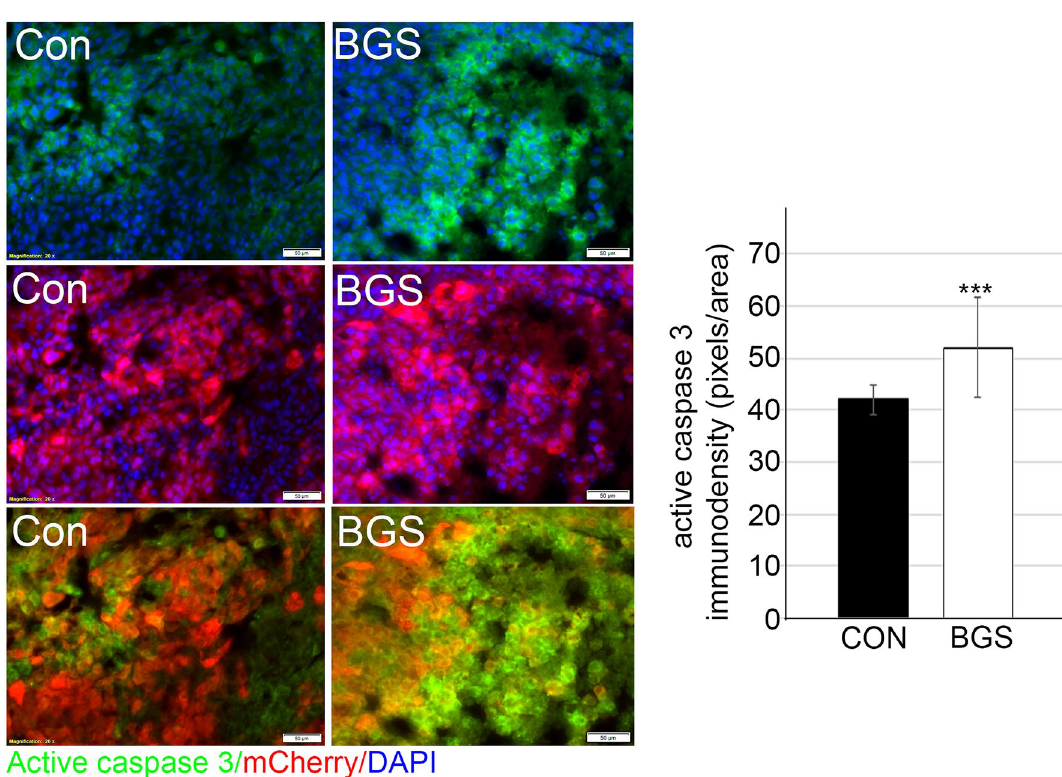
Figure 5. BGS treatment increases RET cell apoptosis. Representative images of the control and BGS treatments for active caspase-3 apoptotic marker expression (green) in the tumor (mCherry). Active caspase-3 density is significantly increased in the BGS-treated group compared to the control group. Results are presented as mean ± SD (n = 7 animals/group; ***p < 0.001). Scale bar 50